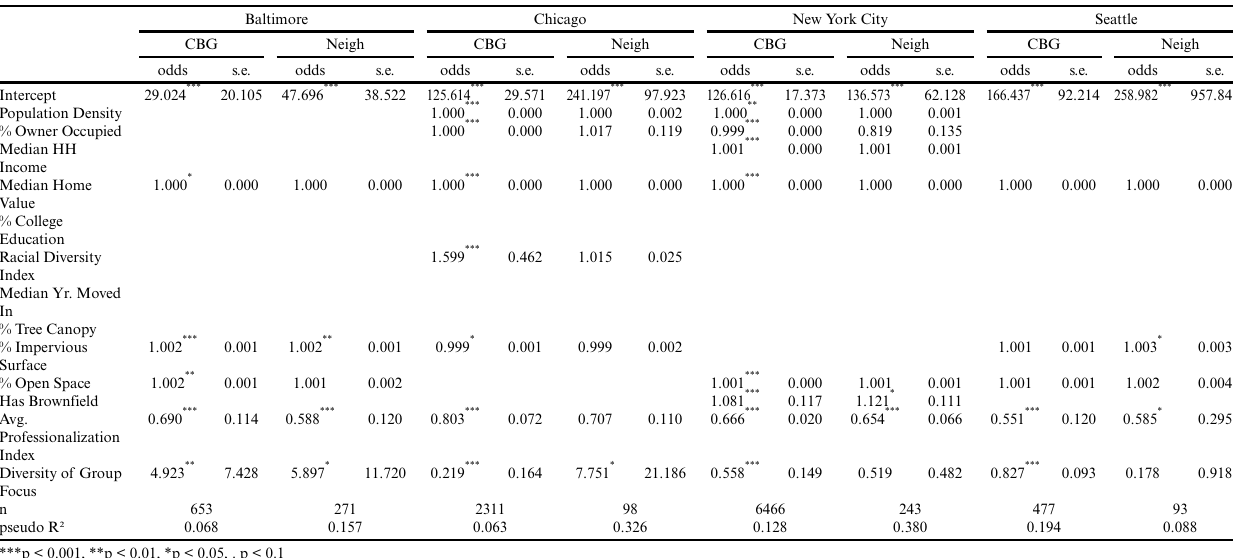
Table 4 . Stepwise Poisson odds ratios (and 95% confidence intervals) by study area city at Census block group (CBG) and neighborhood scales. Starred terms are significant (alpha =